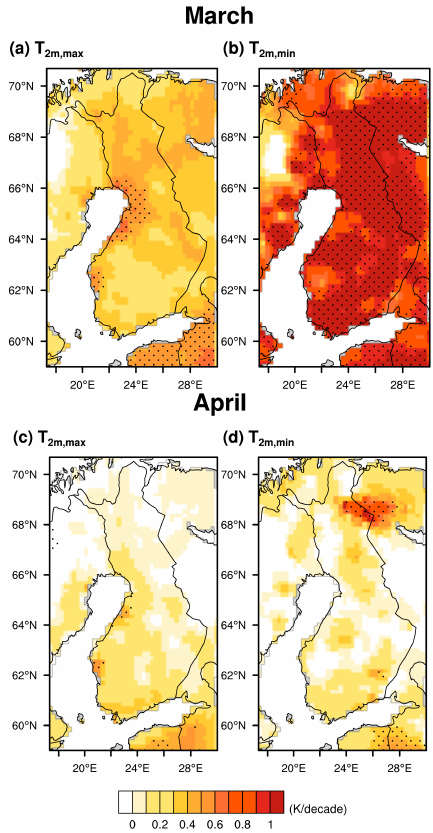
Figure 9. Temperature trends over 40years (1959–1998) for (a, c) monthly mean daily maximum and (b, d) monthly mean daily min- imum surface temperatures of March and April. The areas covered with black dots are statistical significant ( p < 0 .